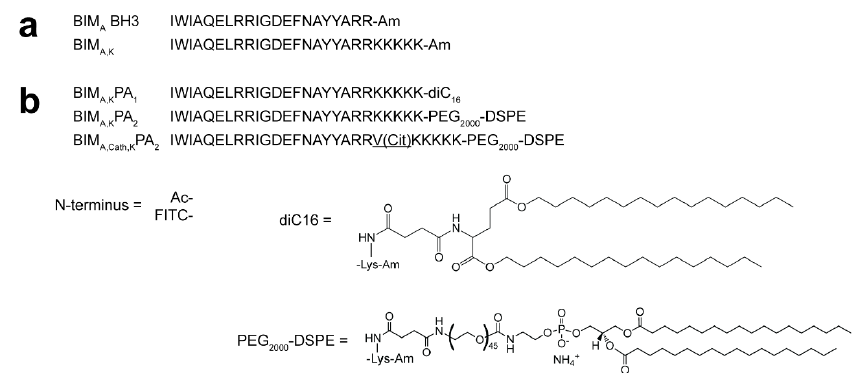
Figure 1. Sequences and structures used in this study. ( a ) BIM A BH3 mimics the BH3 death domain of BIM. To enhance its charge and aqueous solubility, five lysines were added to the C-terminus to create BIM A,K . ( b ) To the BIM A,K peptide, a diC16 lipid tail was added to form BIM A,K PA 1 , and a DSPE- PEG lipid tail was added to form BIM A,K PA 2 . A cathepsin-cleavable linker was also incorporated into BIM A,K PA 2 between the BIM A sequence and the C-terminal lysines and lipid tail to form BIM A,cath,K PA 2 .